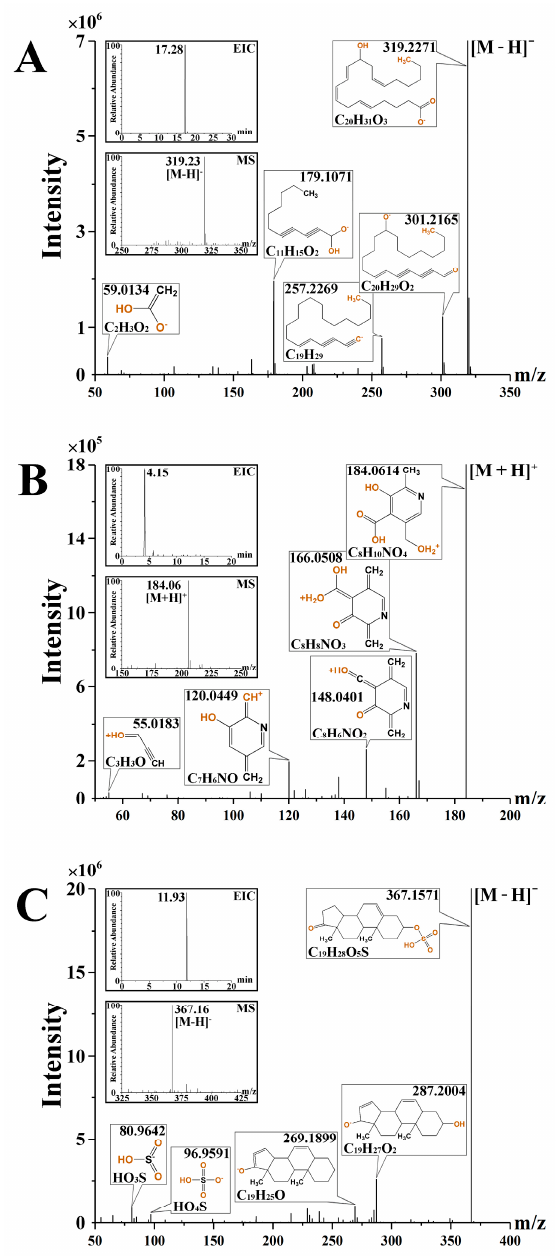
Figure 6. The extracted ion chromatogram, MS and MS/MS spectrum of 12(R)-HETE ( A ), acid ( B ) and dehydroepiandrosterone sulfate ( C 4-Pyridoxic acid ( B ) and dehydroepiandrosterone sulfate ( C ).